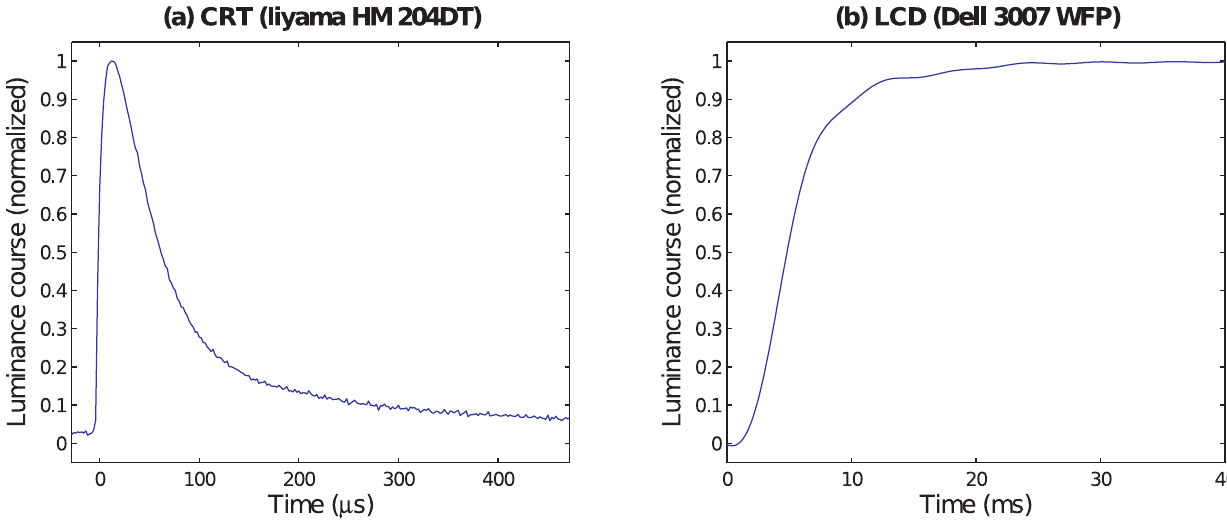
Figure 2. Comparison of CRT and LCD luminance transition signals. The plots show the onset of a green stimulus on a black monitor at time t ~ 0 . The CRT signal shown in ( a ) was measured from an Iiyama HM 204 DT monitor. The LCD signal shown in ( b ) was taken from a Dell 3007 WFP panel after backlight filtering by the division method [13]. Note the different scalings of the abscissas.